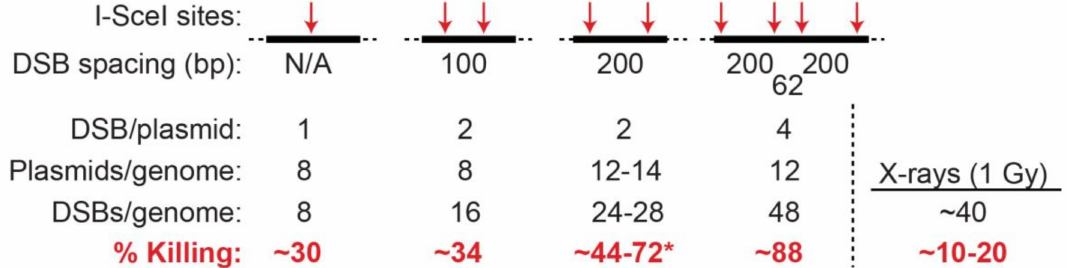
Figure 3. Mimicking the cytotoxicity of high LET radiation with clustered DSBs(DNA double-strand breaks) induced by I-SceI nuclease. Plasmids were created with 1–4 I-SceI nuclease recognition sites spaced from 62–200 bp apart (top; N / A, not applicable). Cell lines were created with 8–14 copies of each plasmid randomly integrated into Chinese hamster ovary cells. Expression of I-SceI induces 8–48 DSBs per genome. Two cell lines were constructed with DSBs located 200 bp apart, with DSB ends either in compatible or incompatible orientation; greater killing was observed with incompatible ends (marked by *). The 4-DSB cluster showed far greater killing per DSB than low LET X-rays. The I-SceI data in this figure were adapted from a report from the Iliakis laboratory